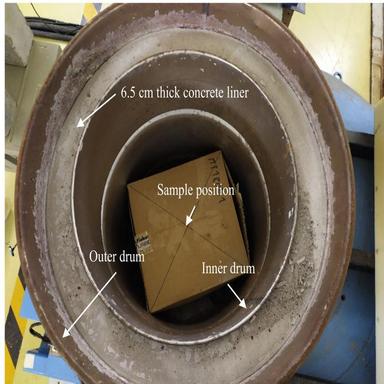
Mock-up drum with a concrete liner.